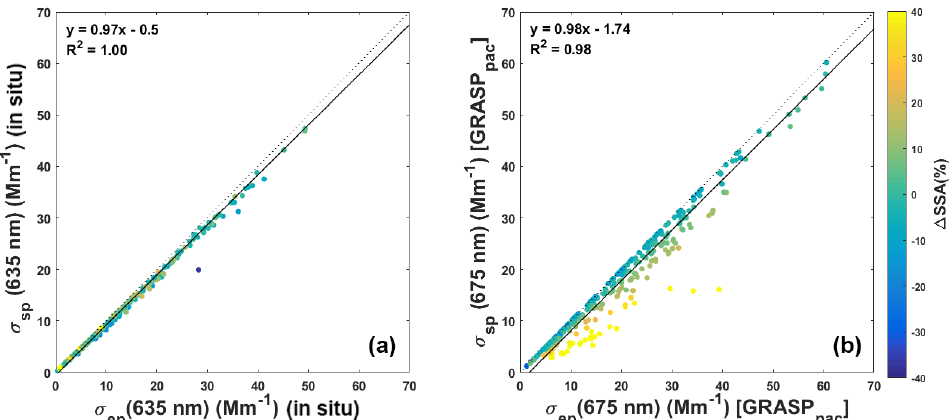
Figure 3. Scatter plots of the hourly averaged aerosol light-scattering and extinction coefficients measured in situ (a) and retrieved with the GRASP pac algorithm (b) . The color scale represents the relative difference in the single-scattering albedo, SSA, between in situ and GRASP pac